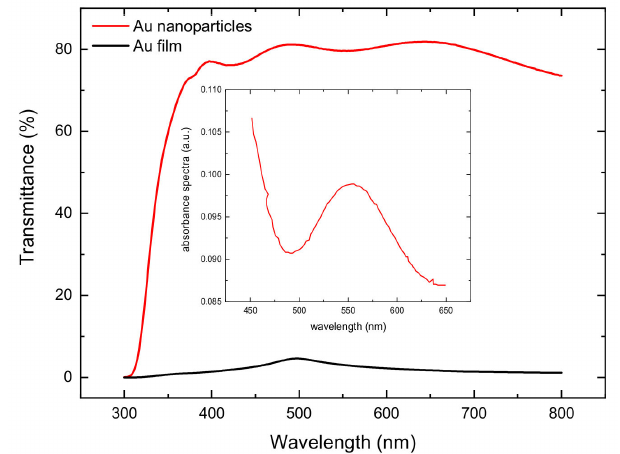
Figure 4. Transmittance spectra: Au nanoparticles (red) and Au film (black). Inset. Absorption spectra of the visible plasmon band of Au nanoparticles on the FTO